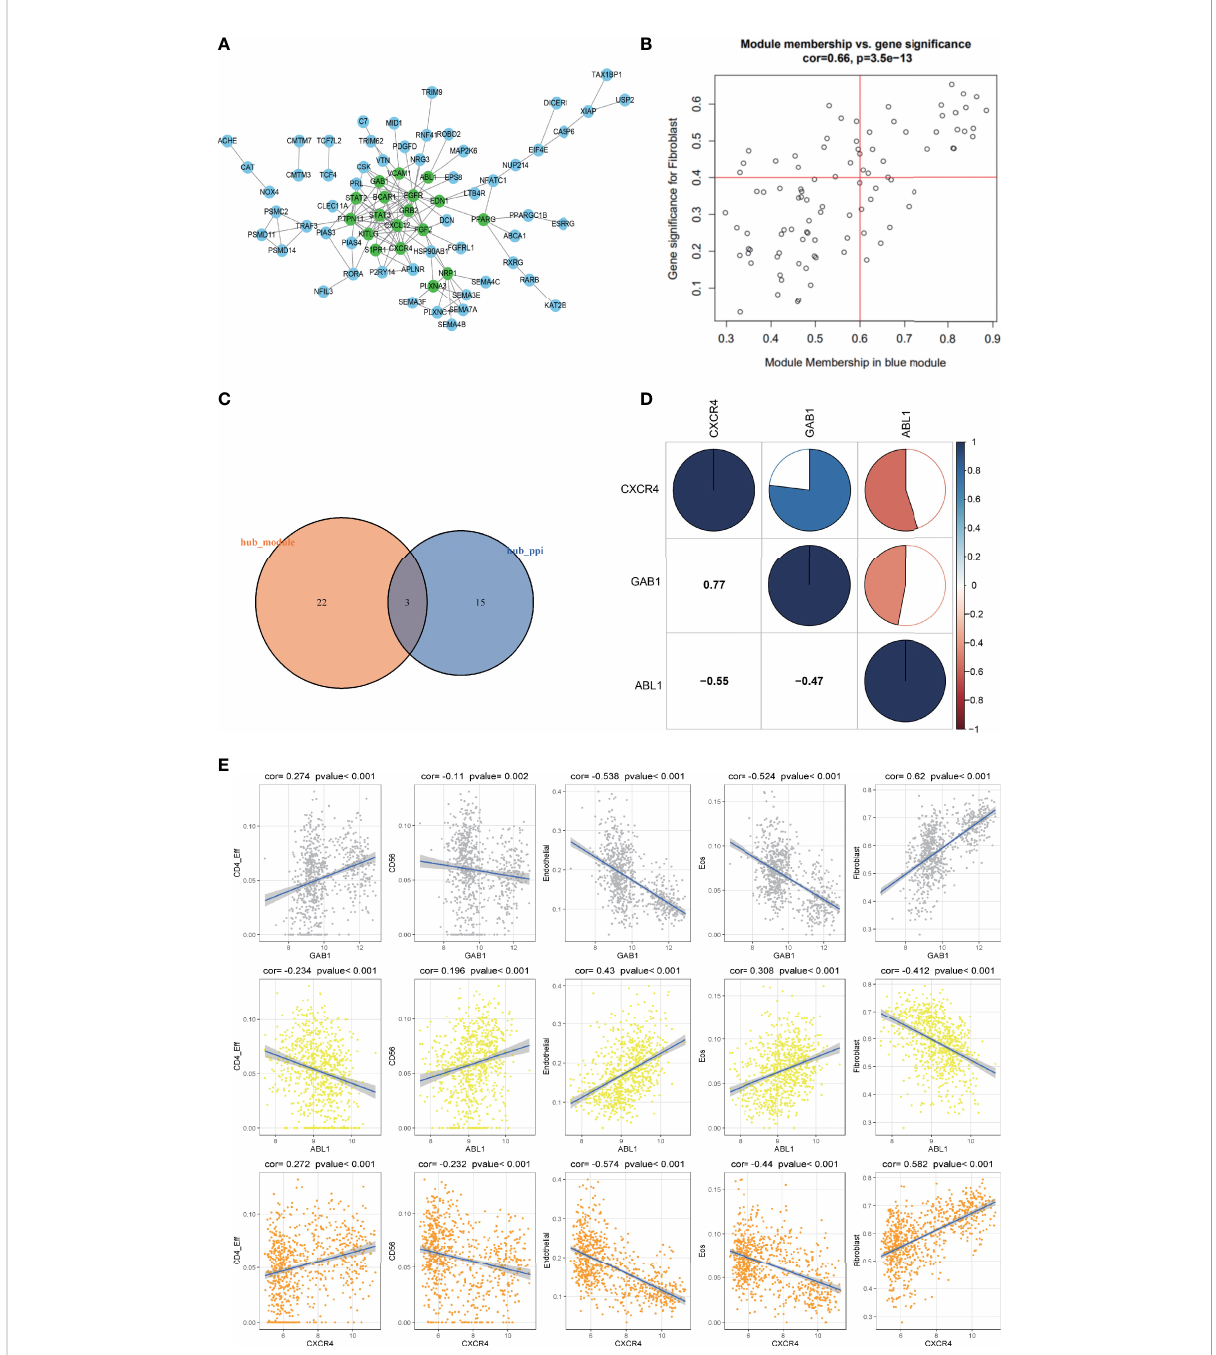
FIGURE 4 The correlation analysis of the hub gene and its relationship with different immune in fi ltrating cells. (A) The protein – protein interaction (PPI) network was constructed by genes in the blue module. The nodes with a green color on the PPI network represent the hub genes. (B) The distribution of gene signi fi cance (GS) and module membership (MM) in the blue module. (C) The intersection of the immune hub gene set of the PPI network (node degree value ≥ 5) and the hub gene set of blue modules (GS >0.4, MM >0.6). (D) Correlation analysis of the four hub genes. Blue represents a positive correlation, and red represents a negative correlation. The larger the sectorial area of the pie graph, the higher the correlation between the two genes. (E) The correlation between hub genes (GAB1, ABL1, CXCR4) and immune in fi ltrating cells (CD4_Eff, Fibroblast cells, Endothelial cells, and the Eos